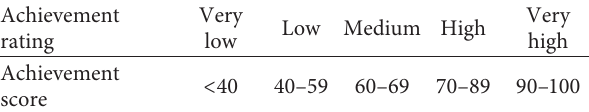
Table 3: The assessment grade of